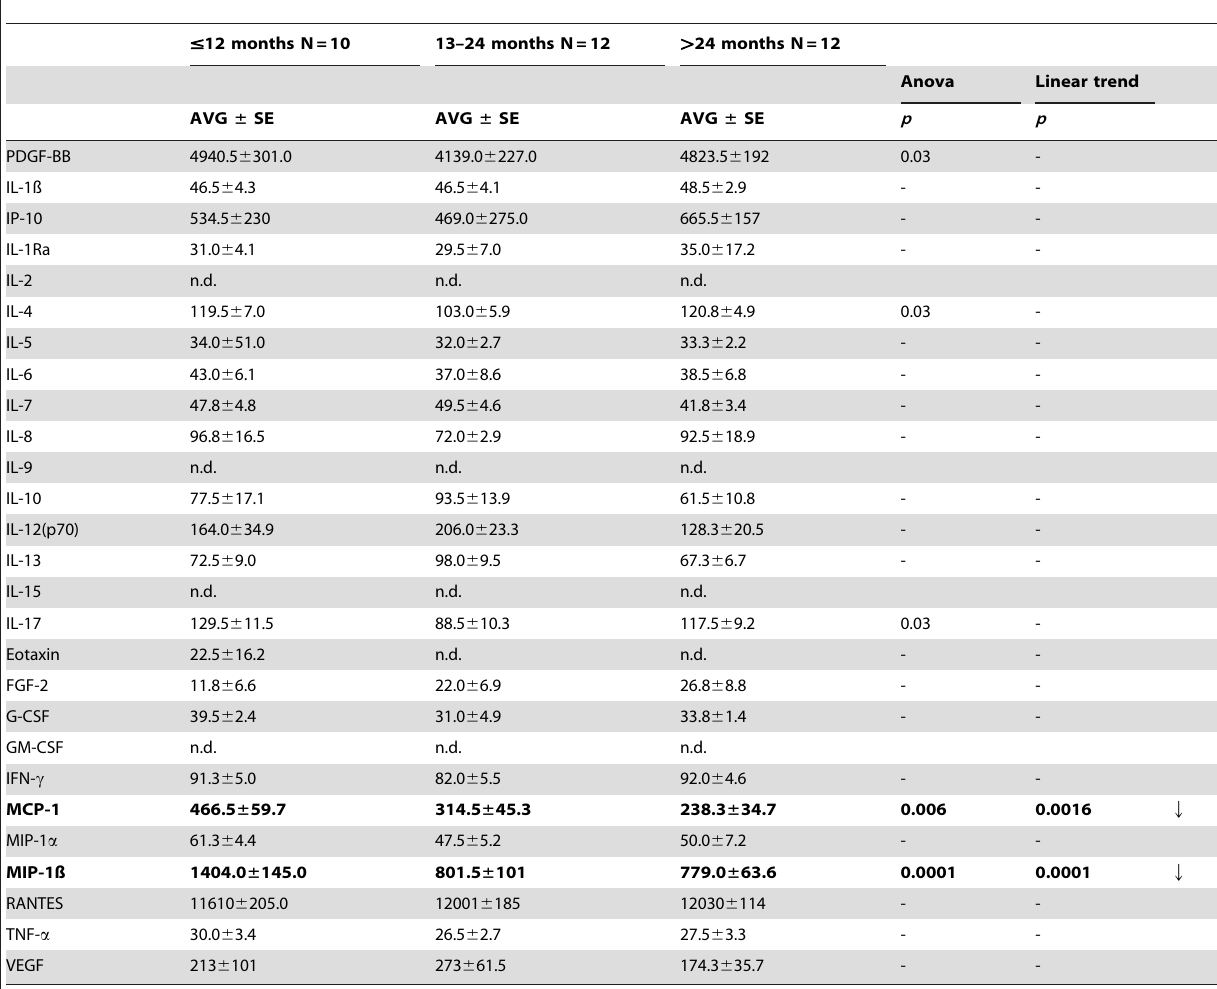
* Values are expressed in pg/ml. n.d. : not